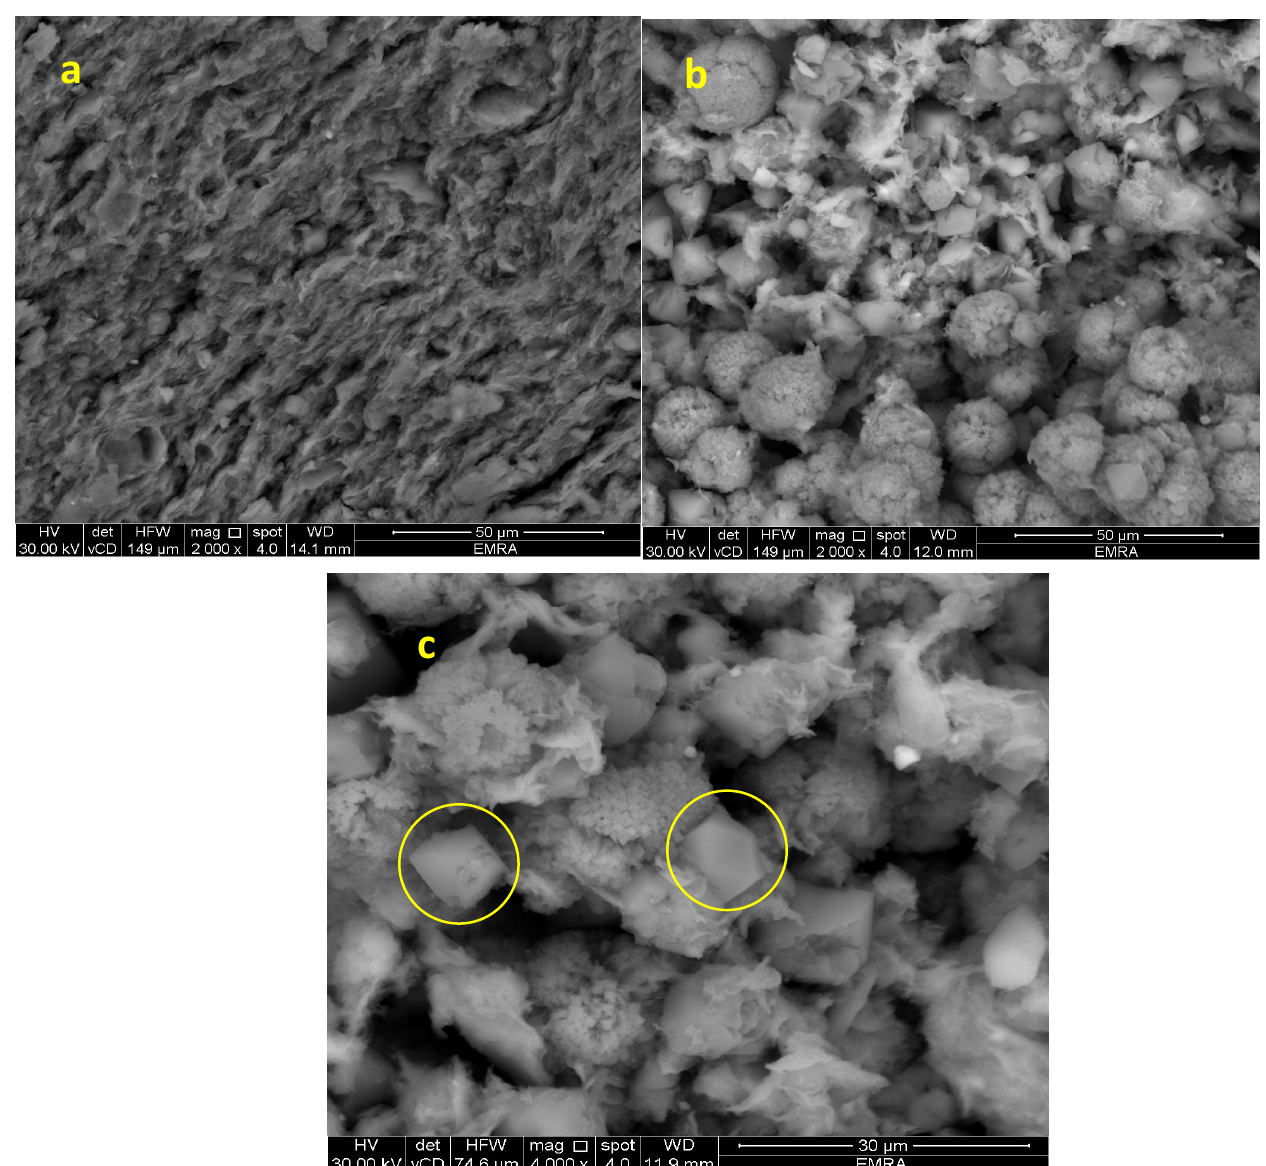
Fig. 4. SEM micrographs of the prepared zeolite from kaolin raw material (a), metakolinte under hydrothermal conditions with Na OH (1.0M) / 90 o C /2days (b) and synthetic zeolite Na-Y (octahedral structure)